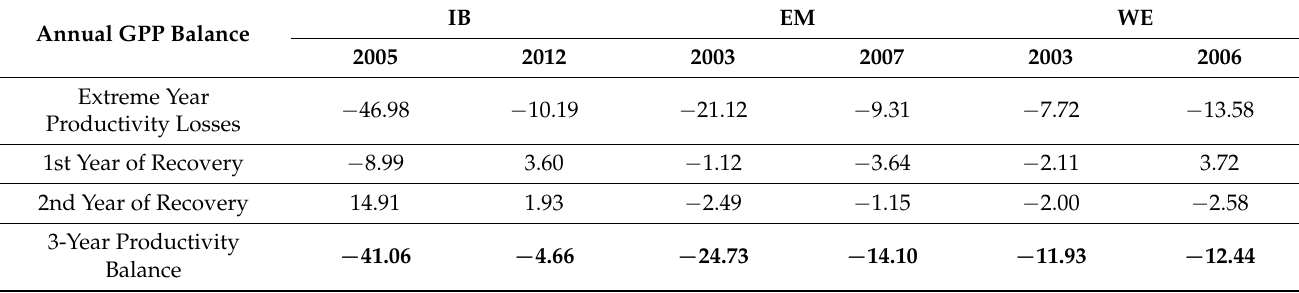
Table 3. Annual GPP balance (TgC/year) relative to the median for all the study cases. The 3-year productivity balance corresponds to the integrated annual values that occurred during the ecological event year and the two following